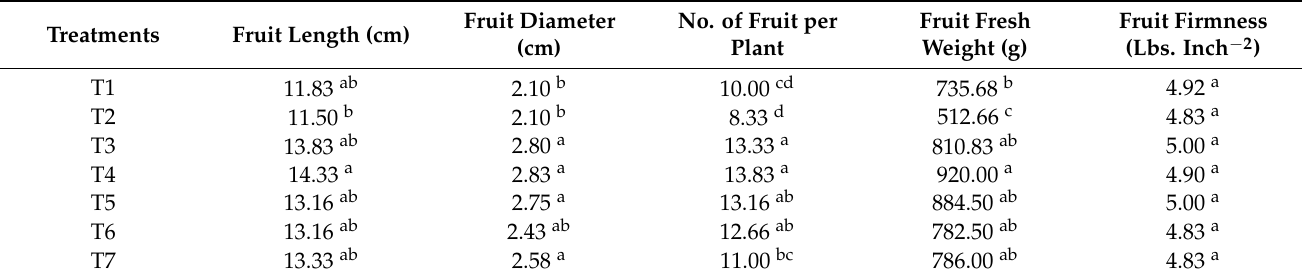
Table 3. Effect of chemical, organic, and biofertilizer treatments on some fruit growth characteristics of cucumber plants grown under greenhouse conditions.